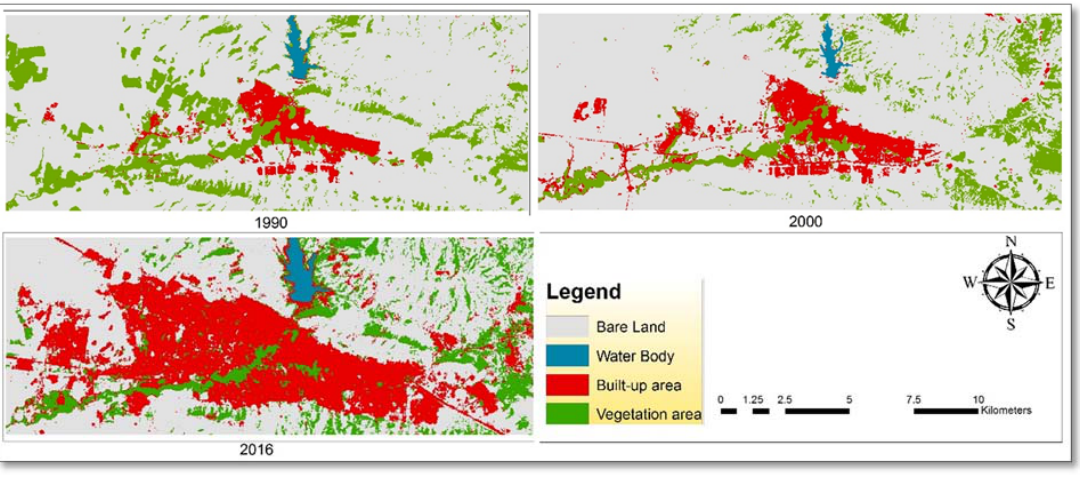
Figure 3. Supervised classification of land use/cover map. Table 3. Shows the quantity of land use change.